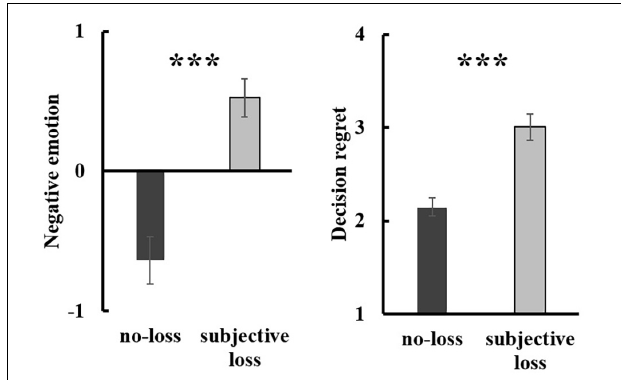
FIGURE 1 | The loss effect on general negative emotion (left) and decision regret (right) in Study 1. Error bars represent standard errors. ***p <